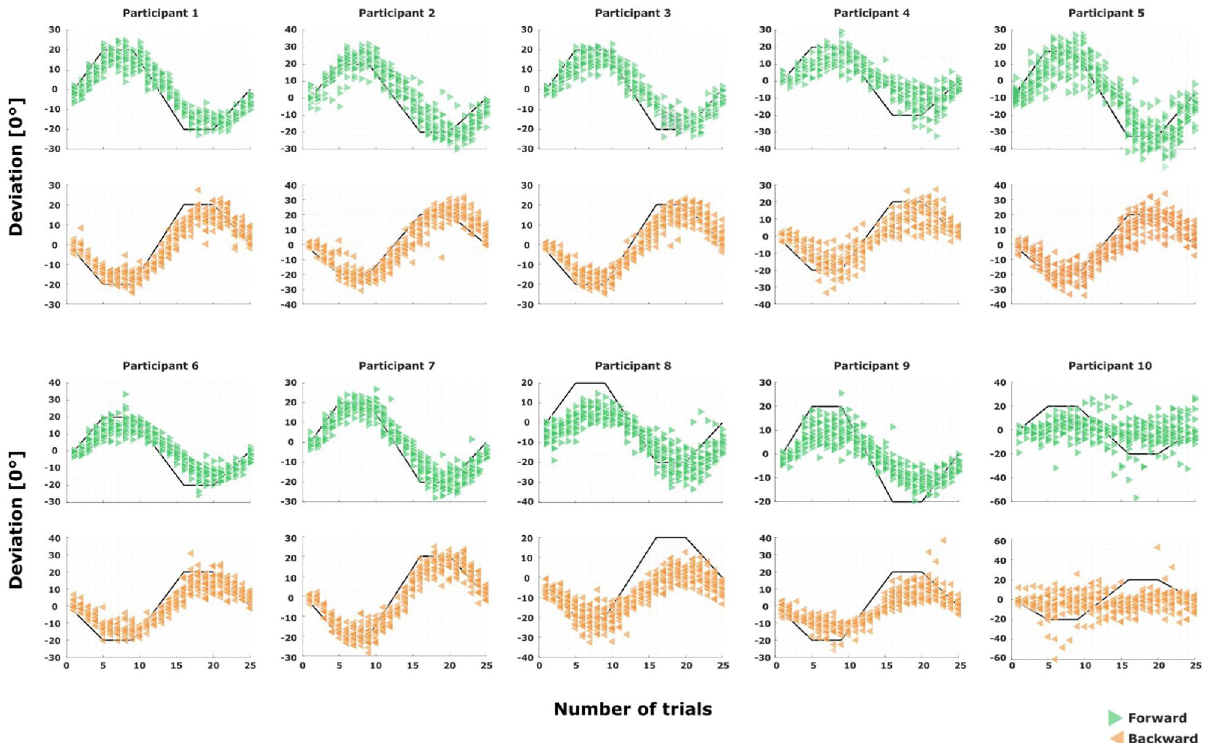
Figure 6. Observed angles in the forward and backward processes. The black line represents the protocol while the filled triangles correspond to both the forward trajectories, first and third rows in green, and the backward trajectories, second and fourth rows in